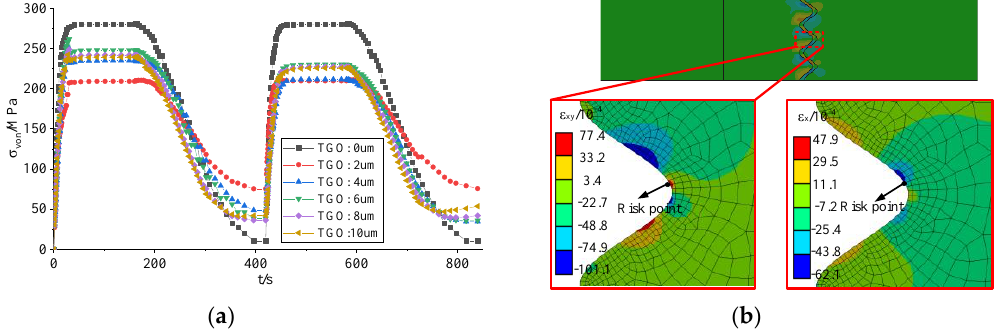
Figure 7. Simulation results of the top coat (TC) layer in ceramic metal tube. ( a ) Maximum von-Mises stress in TC layer; ( b ) Strain contour of 2 µ m.